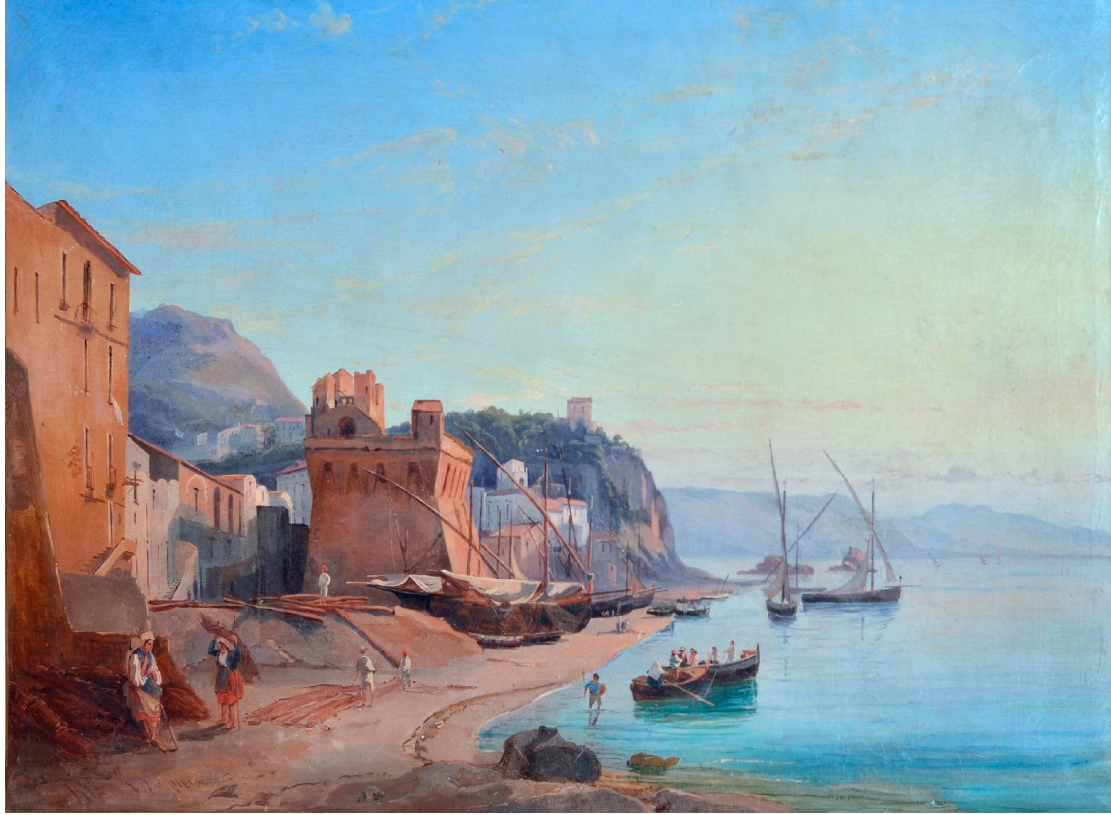
Figure 1. Unknown author, Marina di Vietri, XVI century; oil on canvas Coll. Villa Guariglia, Via Nuova Raito. Raito di Vietri sul Mare